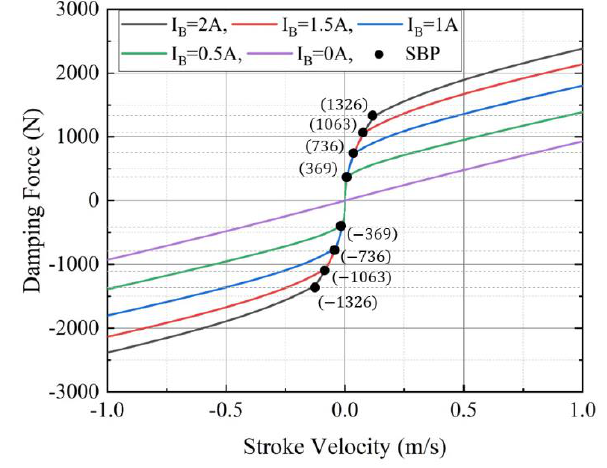
Figure 14. Damping force shaping by slope breaking point (SBP) control.